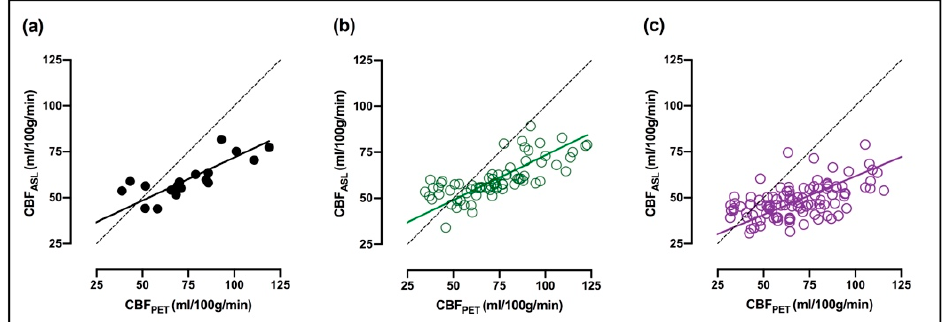
Figure 2. Relation between CBF ASL and CBF PET and corresponding orthogonal regression (solid line) in ( a ) GM, ( b ) cortical regions (green, open circles), and ( c ) subcortical regions (purple, open circles). The dashed line is the line of identity.